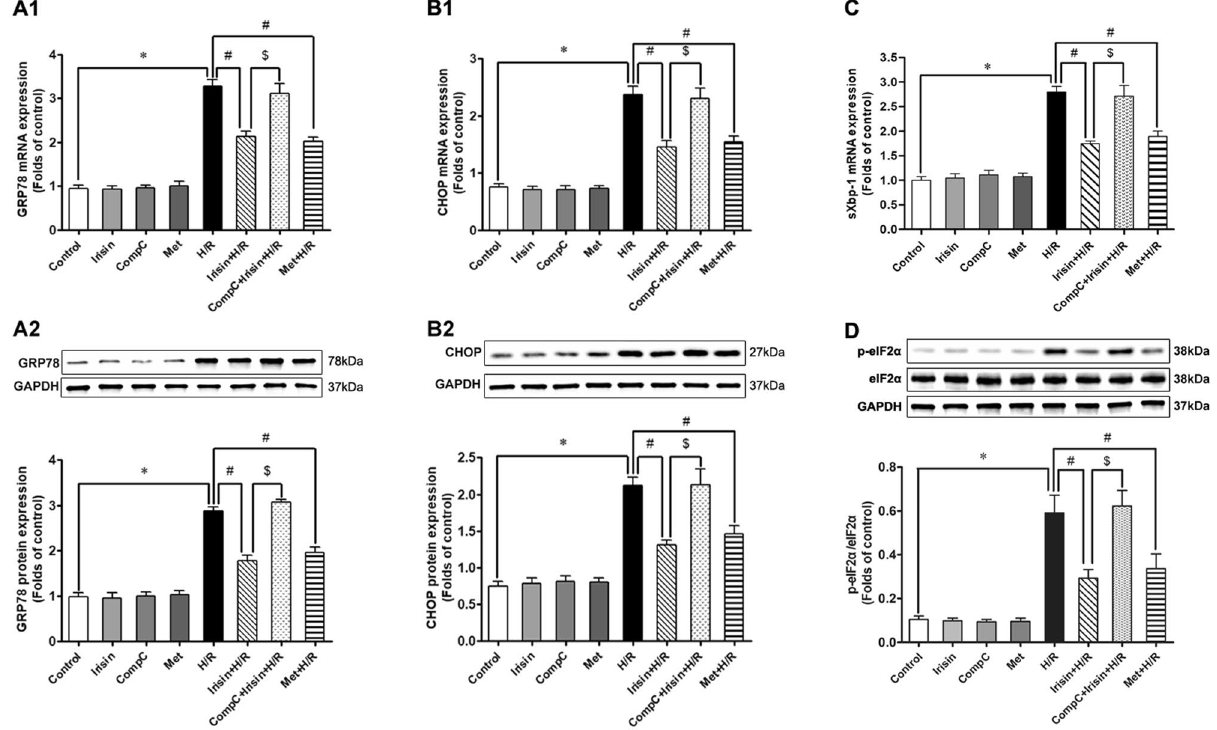
Figure 7. Irisin showed its protective effects against H/R injury-induced ER stress in an AMPK-dependent manner. AMPK activator metformin showed the same effect as irisin in attenuating ER stress induced by H/R exposure. AMPK potent inhibitor compound C pre-treatment abolished cardioprotection of irisin on H/R cardiomyocytes. *P < 0.05 versus control group, # P < 0.05 versus H/R group, $ P < 0.05 versus Irisin + H/R group, n =